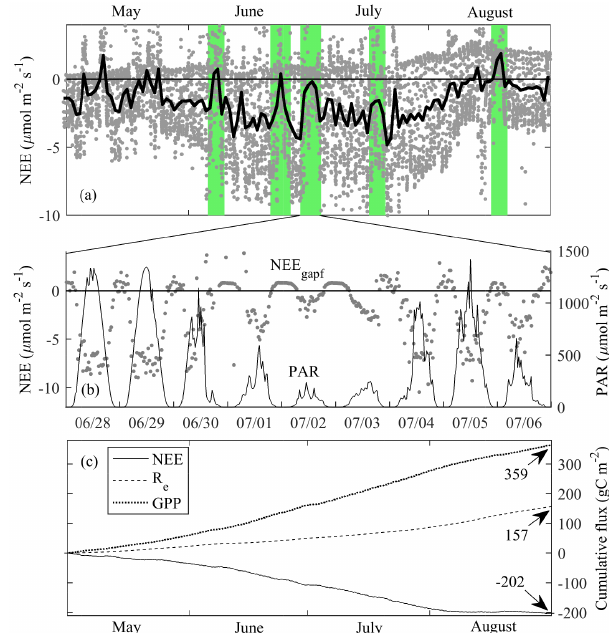
Figure 8. (a) Seasonal variation in the gap-filled NEE; the grey dots correspond to 30min averages and the black line corresponds to the daily averages. The major front passage events are marked with green. (b) Measured NEE and PAR during the third frontal event. (c) Cumulative gap-filled NEE, R e , and GPP.